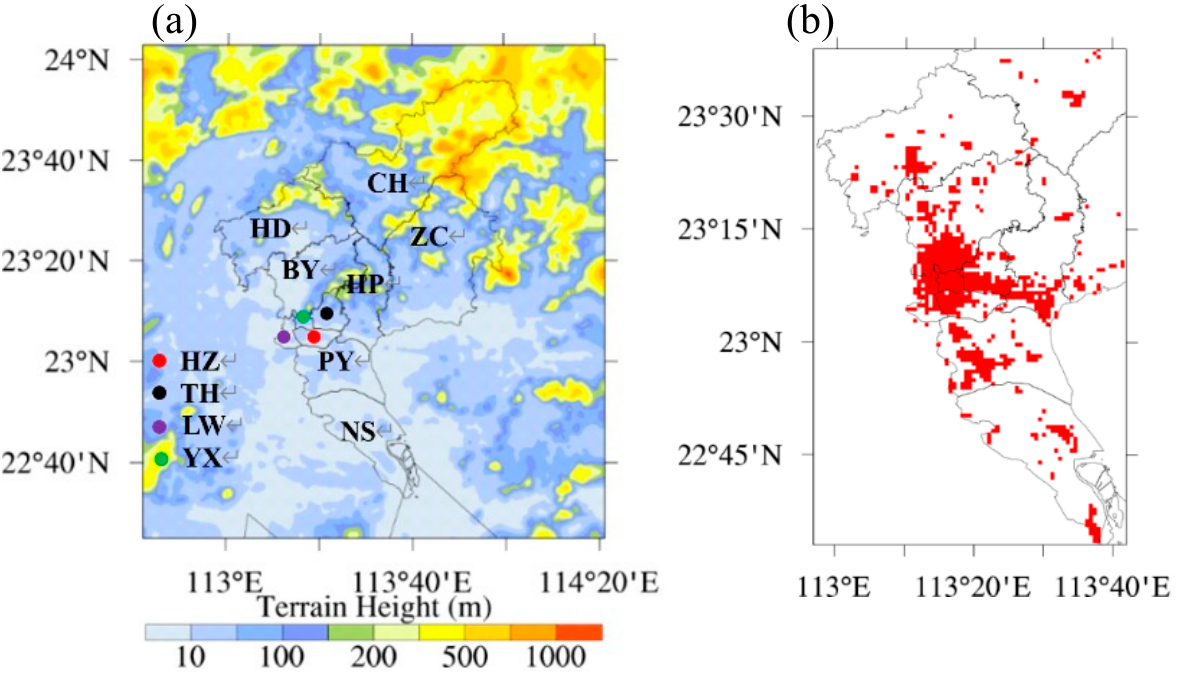
Figure 1. Simulated domain 4 ( a ) and the study area (( b ), red shading is the urban land-use type). The black acronyms in the left panel are as follows: Yuexiu District (YX), Haizhu District (HZ), Liwan District (LW), Tianhe District (TH), Baiyun District (BY), Huadu District (HD), Huangpu District (HP), Panyu District (PY), Nansha District (NS), Conghua District (CH), and Zengcheng District (ZC).